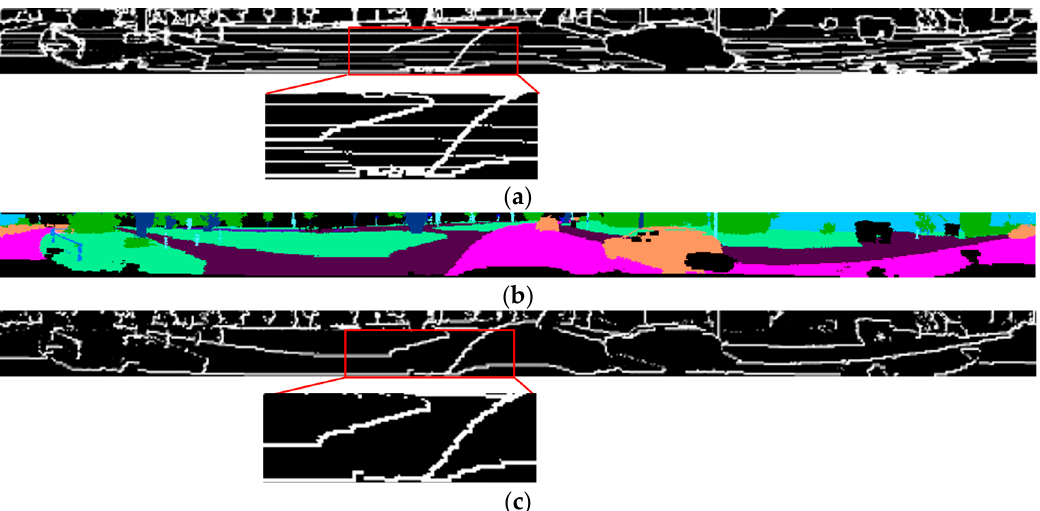
Figure 3. Process of making an edge map. ( a ) Edge map affected by the stripe patterns; ( b ) Inpainted GT semantic labels; ( c ) Edge map unaffected by the stripe patterns.